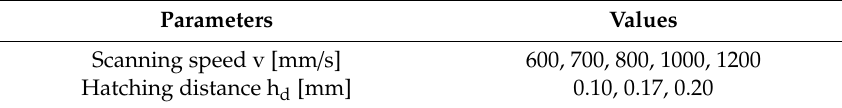
Table 1. Main process parameters adopted for A357